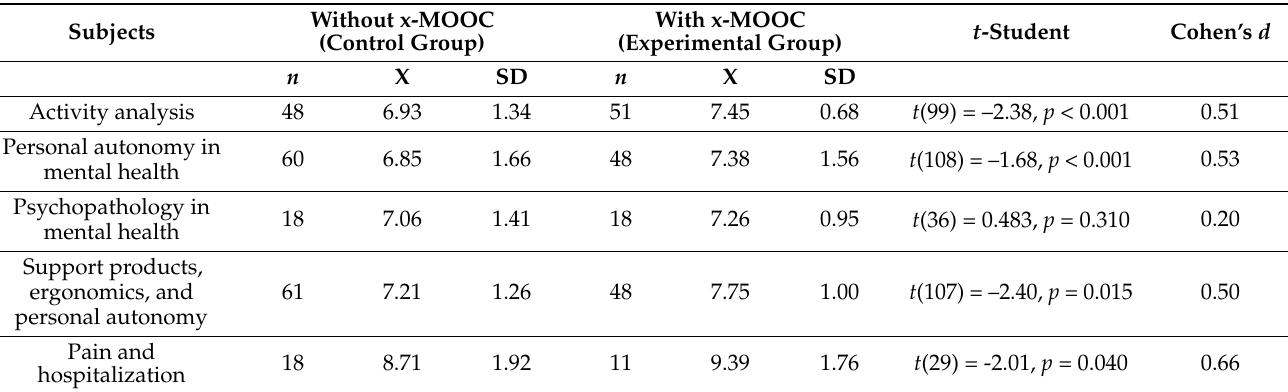
Table 2. Descriptive statistics and comparison of means in grades between the groups without and with MOOC in five subjects of the Degree in Occupational Therapy and the Degree in Physical Therapy.